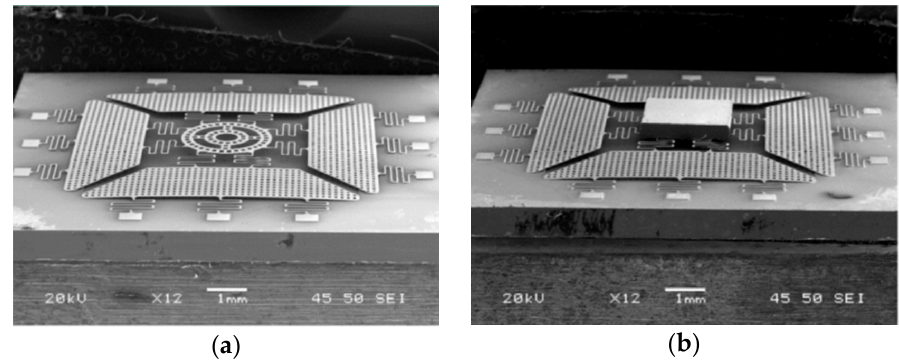
Figure 23. Prototype pf the translation micromirror: ( a ) Nickel film; ( b ) nickel film bonded with the mirror plate. (Reprinted with permission from Reference [46] IOP Publishing, Ltd.).